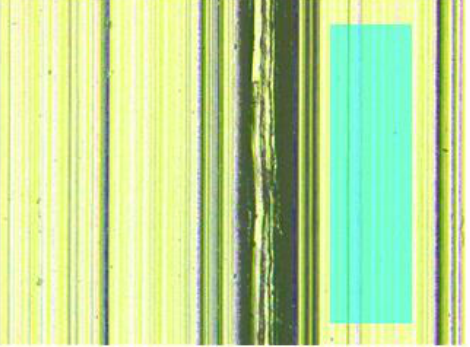
Table 8. The optimal micro cutting parameters. Figure 12. The surface roughness at the rotation speed of 2000 r/min. Figure 12. The surface roughness at the rotation speed of 2000 r / min.